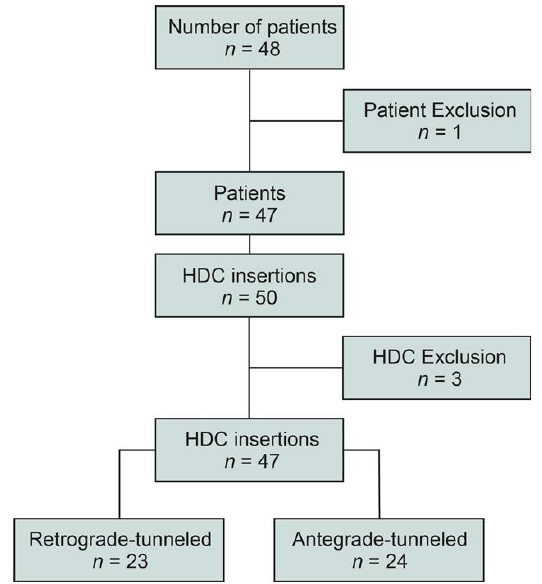
Figure 1. Total patient cohort. STROBE flow chart of patient disposition with the indication of tunneled HDC insertion. Abbreviations: HDC, hemodialysis catheter; STROBE, Strengthening the Reporting of Observational Studies in Epidemiology.